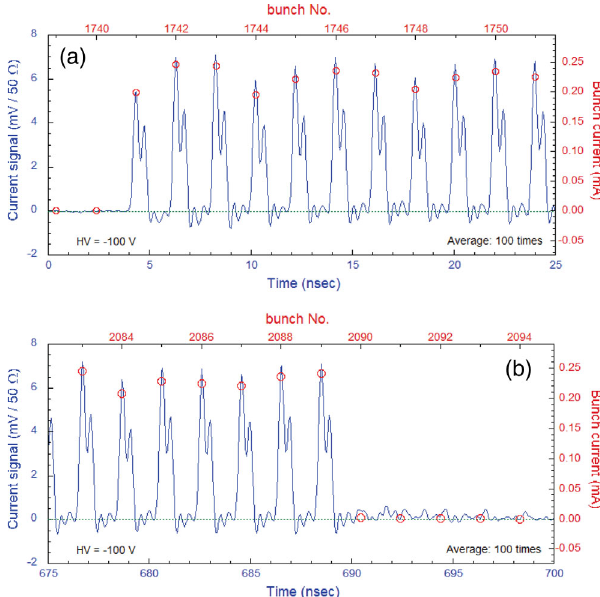
FIG. 19. Response of the pulse height to incident x rays, (a) head of pulse train, (b) tail of pulse train. The pulse waveform is indicated by the blue line and the bunch current is indicated by the red circles. The baseline is marked with a dotted line. The applied voltage of the charge collecting electrodes is set to − 100